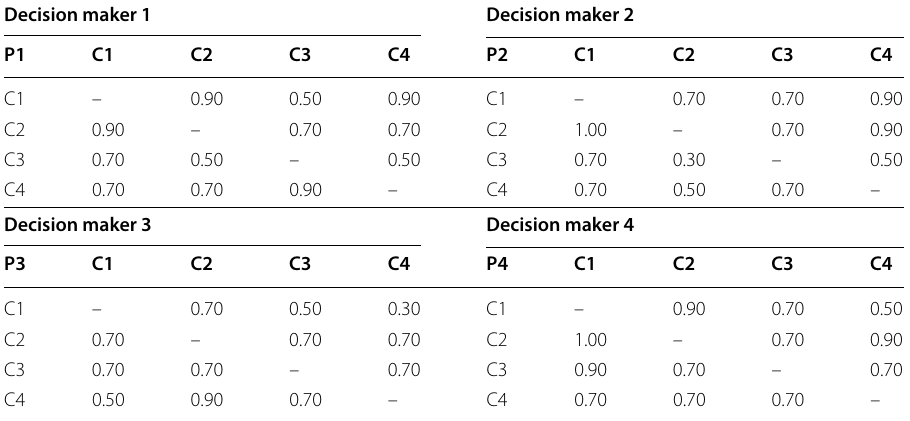
Table 15 Consensus-based fuzzy preference relations for the donation-based crowdfunding alternative (the first-round evaluation) Decision maker 1